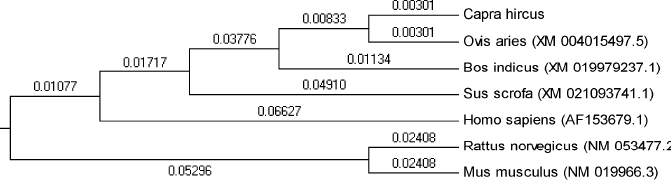
Figure 1. Phylogenetic tree based on MCD gene sequences of 7 representative animals constructed by MEGA 5 software. The number on the branch line represents the evolutionary branch length.